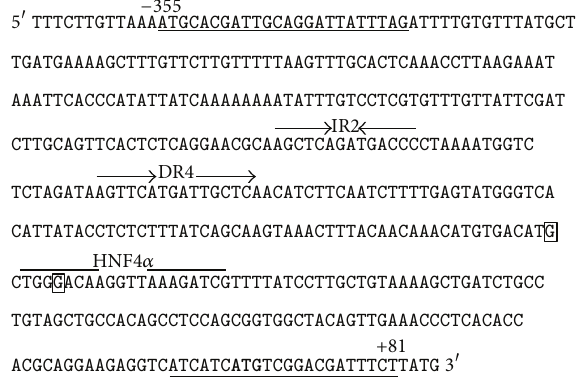
Figure 1: The DNA sequence within SULT2A1 promoter region ( − 367 to +85). The positions of the studied SNPs, that is, rs11569683, rs112433193, are marked in squares. The PXR binding sites are represented by IR2 and DR4 motif. The HNF4 alpha binding site is marked. The location of primers used in the sequencing of HNF4alpha and PXR binding sites is